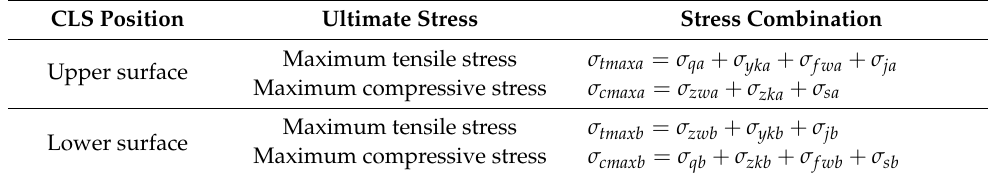
Table 1. Ultimate stress load combination a